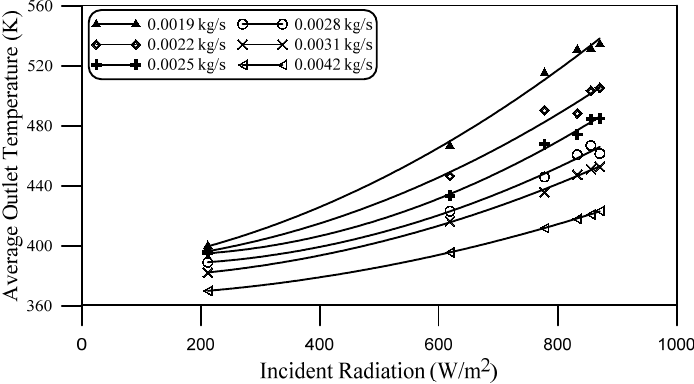
Figure 9. Daily profile of rate of generated steam mass for a 0.005 m diameter tube in a winter day.